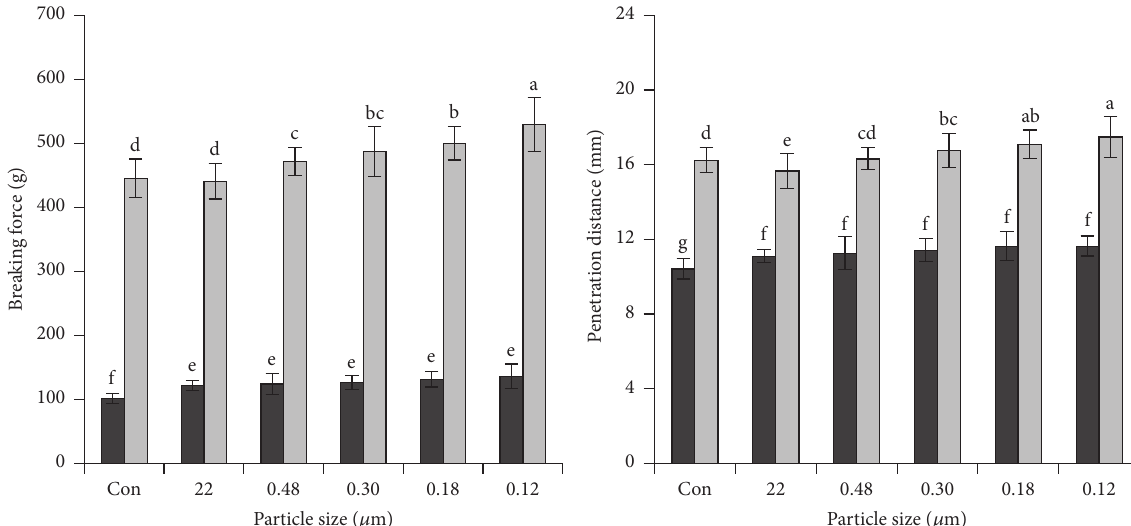
Figure 2: Breaking force and penetration distance of surimi gels with different size of fish bone particles and thermal treatments. Con: control sample, without added fish bone. Black bars: gel cooked at 90 ∘ C for 30 min. Grey bars: gel incubated at 40 ∘ C for 1 h followed by 90 ∘ C cooking for 30 min. Different lowercases above the error bar indicate significant differences among samples with fish bone of different particle size ( 𝑃 < 0.05 ).